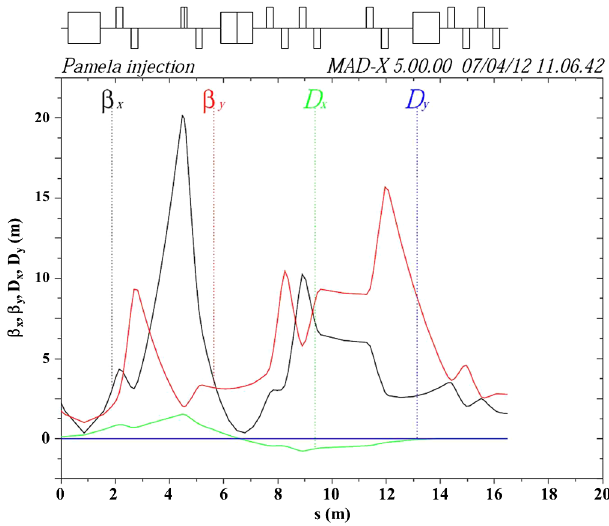
FIG. 33. Horizontal and vertical betatron functions in the carbon line obtained via MAD-X (again in the inverse